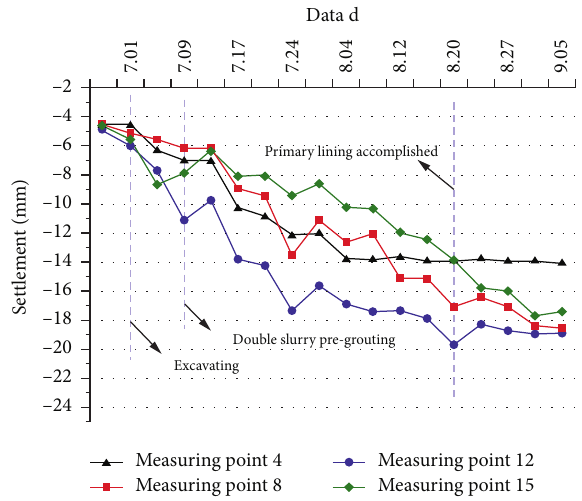
Figure 15: Building subsidence